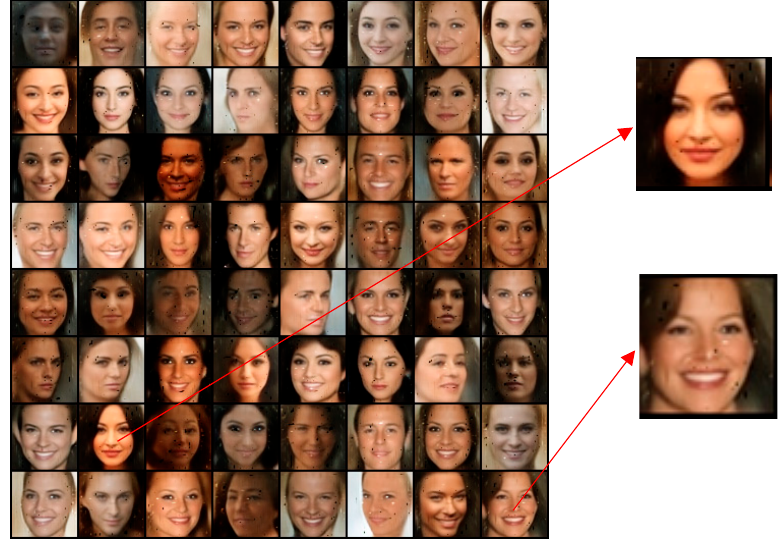
Figure 6. Images with the size of 64x64 generated by the BEGAN model.